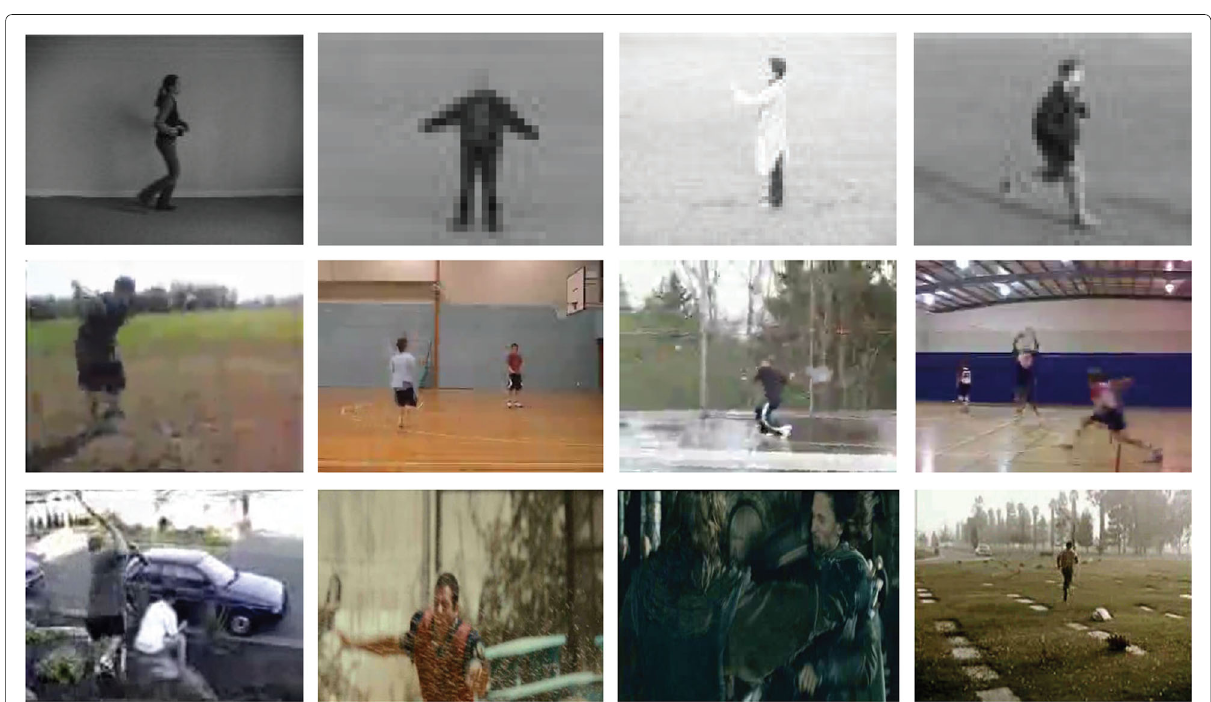
Fig. 1 Sample videos from low-quality subsets of the KTH, UCF-YouTube, and HMDB datasets. The top row are samples from KTH, the middle row are samples from UCF-YouTube, and the bottom row are samples from HMDB. We can observe that the videos are severely compromised by many quality-related factors such as low resolution, lossy compression, and camera motion blurring. As such, the characterization of actions from these videos would be much more